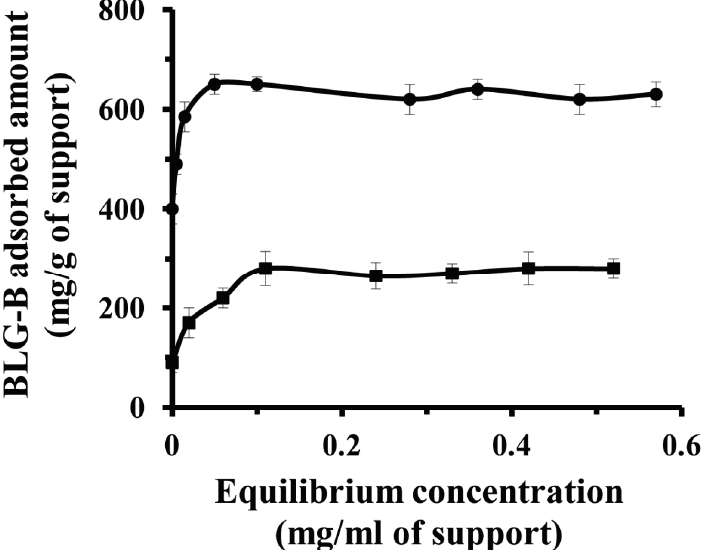
Figure 2. Effect of initial protein concentration on the adsorption of BLG-B on KIT-6 ( ■